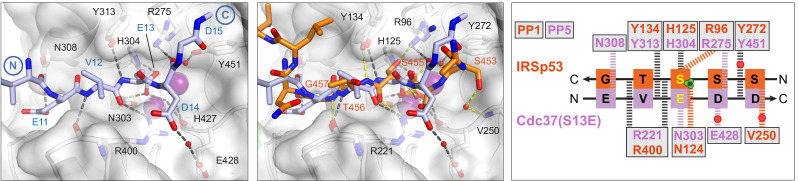
Opposite polarity of substrate binding to PP5 and Phactr1/PP1.Left: the PP5-Cdc37(S13E) complex (Oberoi et al., 2016). White surface, PP5; lilac sticks, Cdc37(S13E). Centre, superposition of the PP5-Cdc37(S13E) and Phactr1/PP1-IRSp53 structures. Right, comparison of molecular interactions with substrates at the catalytic site residues of PP5 (lilac) and PP1 (orange). Hydrogen bonds are shown as thick dashed lines: grey for both substrates; colour, for specific substrate.